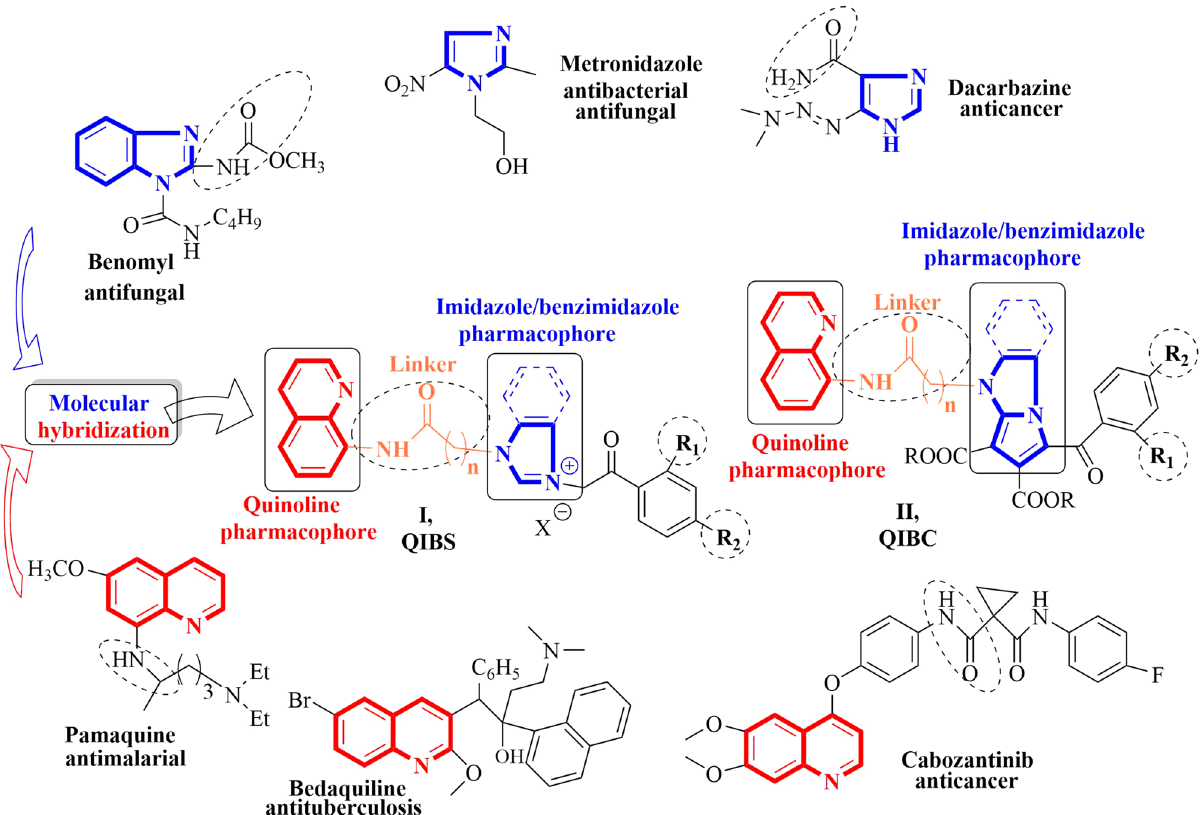
Figure 1. Design in the class of hybrid quinoline–imidazole/benzimidazole derivatives QIBS and QIBC